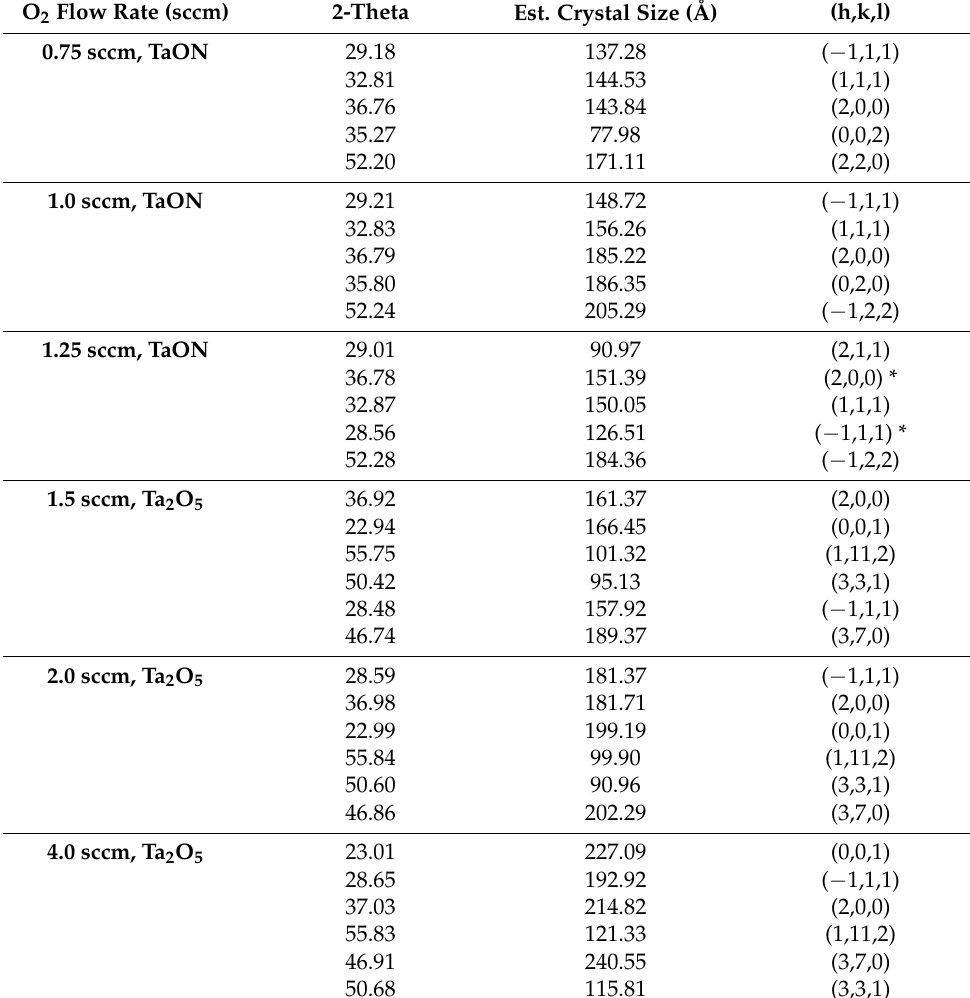
Table A1. Cont. O 2 Flow Rate